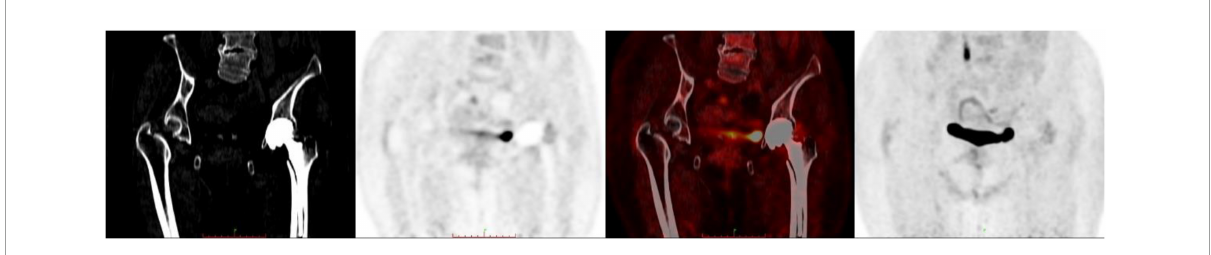
FIGURE6 Case of interval time < 6 months.